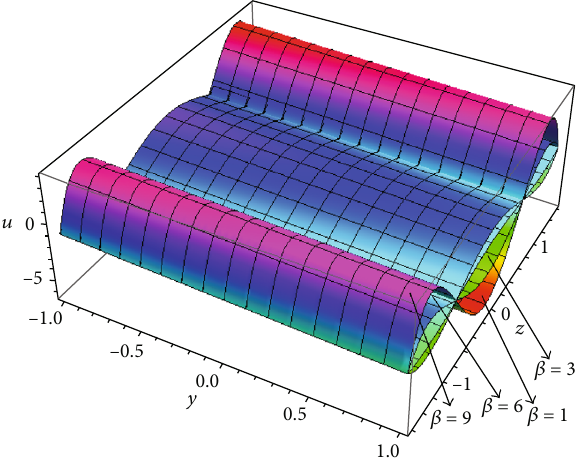
Figure 17: Velocity pro fi le for di ff erent values of β . The other parameters are φ = 0 : 6 , x = 0 , Q = − 0 : 5 , We = 0 : 3 , and n = 2 .